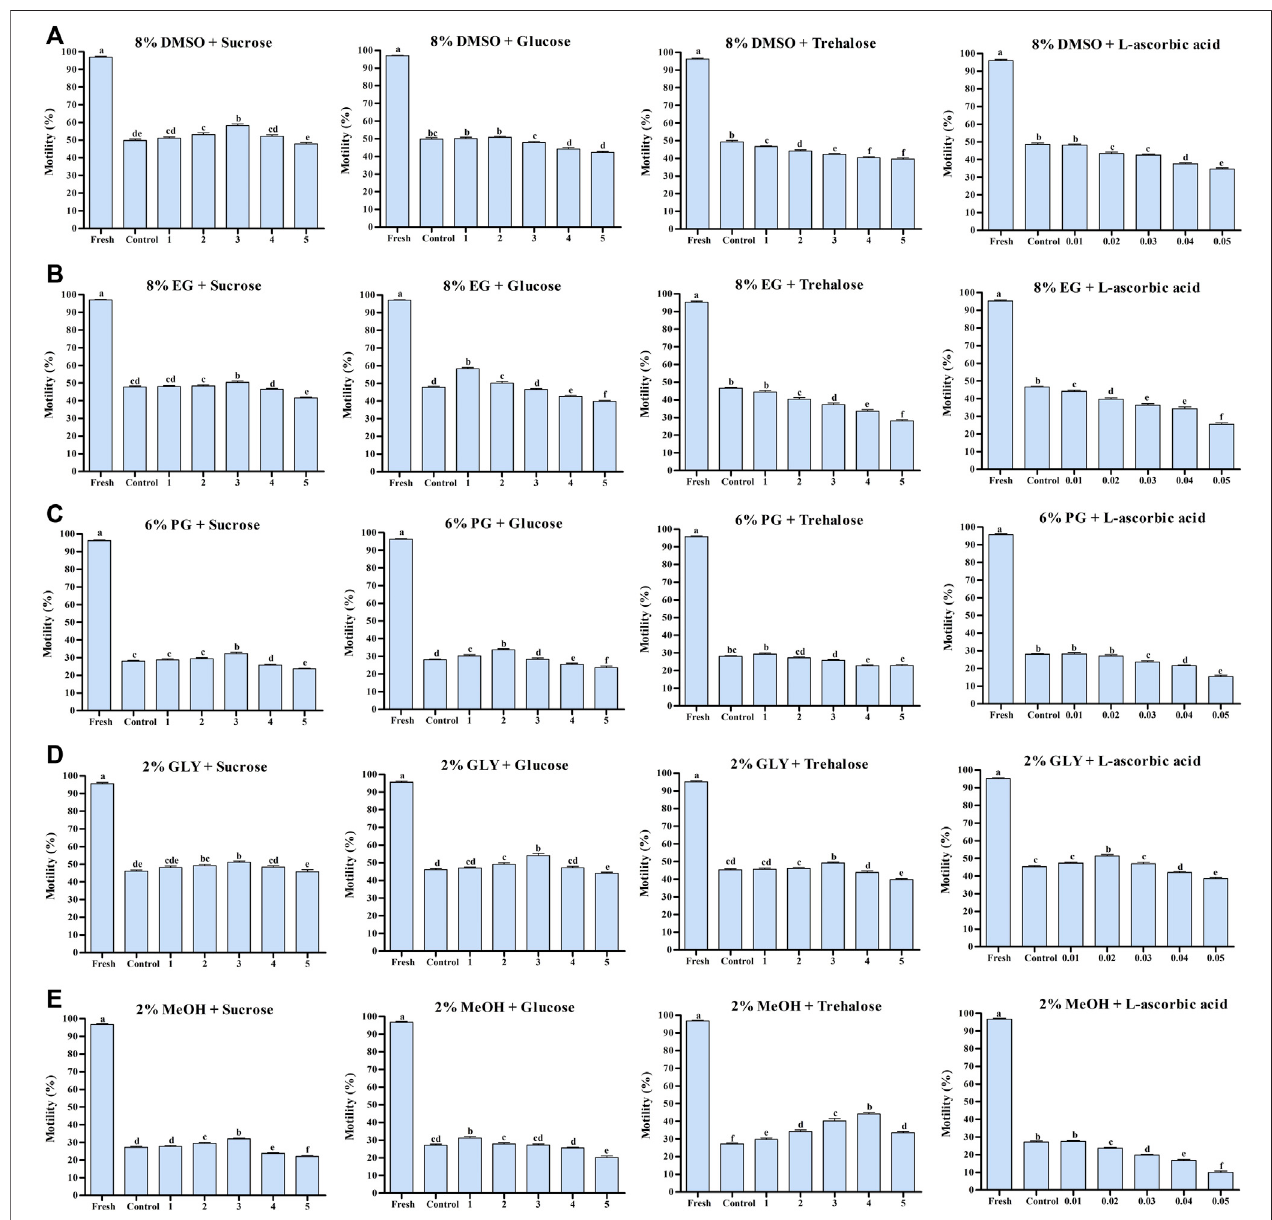
FIGURE1| Effectsofsaccharides(sucrose,glucose, andtrehalose)andvitamin( L -ascorbicacid)onthepost-thawsperm qualityofPaci fi cabalone. (A) Post-thaw motility of sperm cryopreserved using different concentrations of saccharides (1, 2, 3, 4, and 5%) and vitamin (0.01, 0.02, 0.03, 0.04, and 0.05%) combined with 8% DMSO. (B) Post-thaw motility ofsperm cryopreserved using different concentrations ofsaccharides(1, 2, 3,4, and 5%) and vitamin (0.01, 0.02, 0.03, 0.04, and0.05%) combined with 8% EG. (C) Post-thaw motility of sperm cryopreserved using different concentrations of saccharides (1, 2, 3, 4, and 5%) and vitamin (0.01, 0.02, 0.03, 0.04, and 0.05%) combined with 6% PG. (D) Post-thaw motility of sperm cryopreserved using different concentrations of saccharides (1, 2, 3, 4, and 5%) and vitamin(0.01,0.02,0.03,0.04,and0.05%)combinedwith2%GLY. (E) Post-thawmotilityofspermcryopreservedusingdifferentconcentrationsofsaccharides(1,2,3, 4, and 5%) and vitamin (0.01, 0.02, 0.03, 0.04, and 0.05%) combined with 2% MeOH. Signi fi cant difference ( p < 0.05) is denoted by different